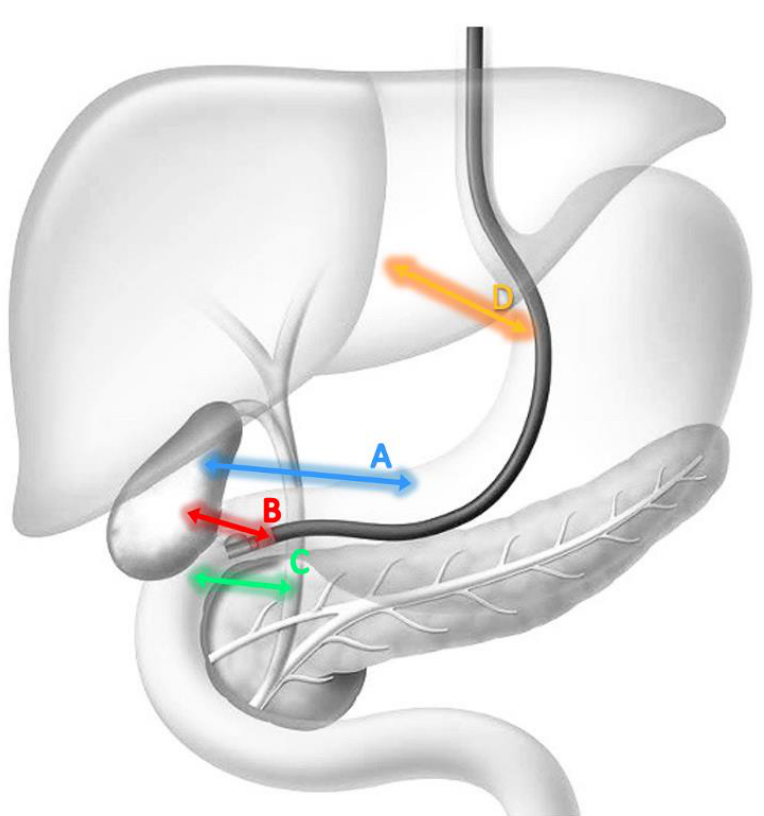
Figure 2. This figure describes the EUS-guided drainage techniques: ( A ) Cholecystogastrostomy; ( B ) cholecystoduodenostomy; ( C ) choledochoduodenostomy; ( D ) ( B ) cholecystoduodenostomy; ( C ) choledochoduodenostomy; ( D ) hepaticogastrostomy.